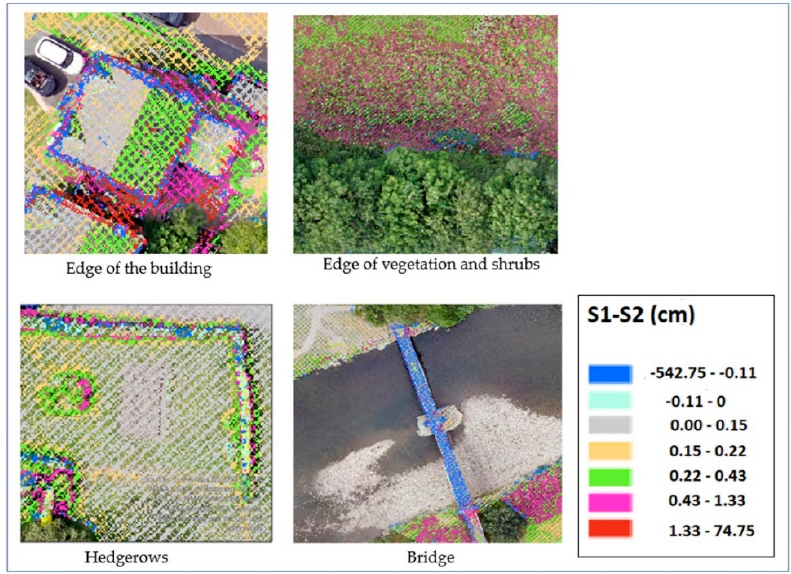
Figure 6. Spatial distribution of differences in elevation (cm) between S1 and S2 on various features.